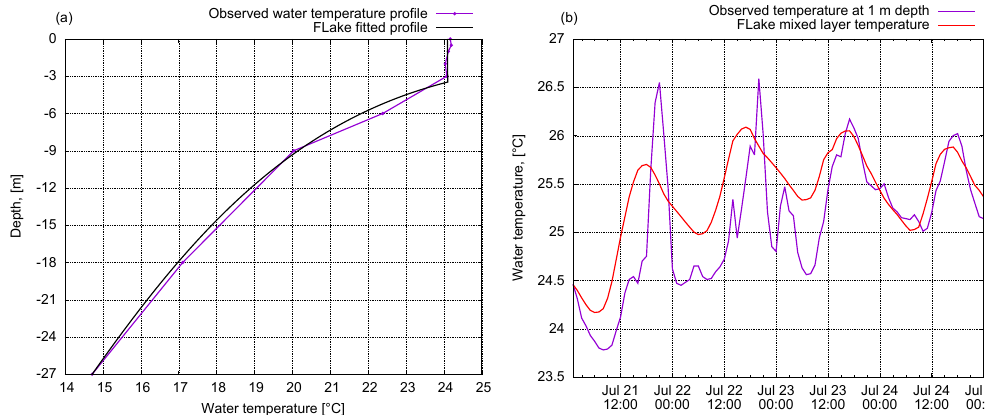
Figure 2. Water temperature observed and fitted profiles on 21 July, 00:00UTC at the Montante platform (a) and comparison of upper level water temperature between measurements and FLake results (b)